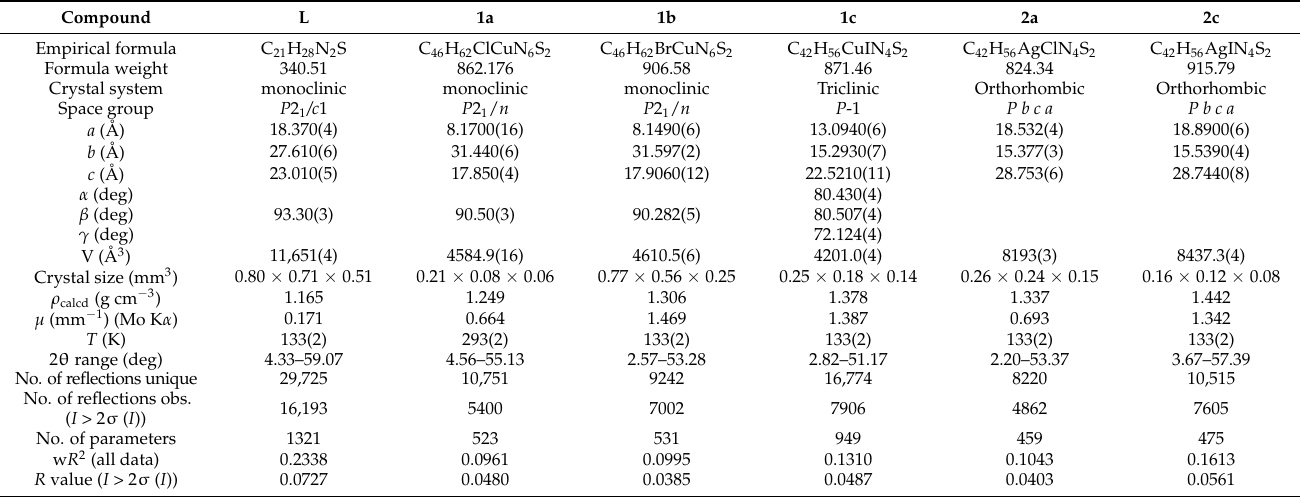
Table 1. Crystallographic data for L , 1a , 1b , 1c , 2a, and 2c